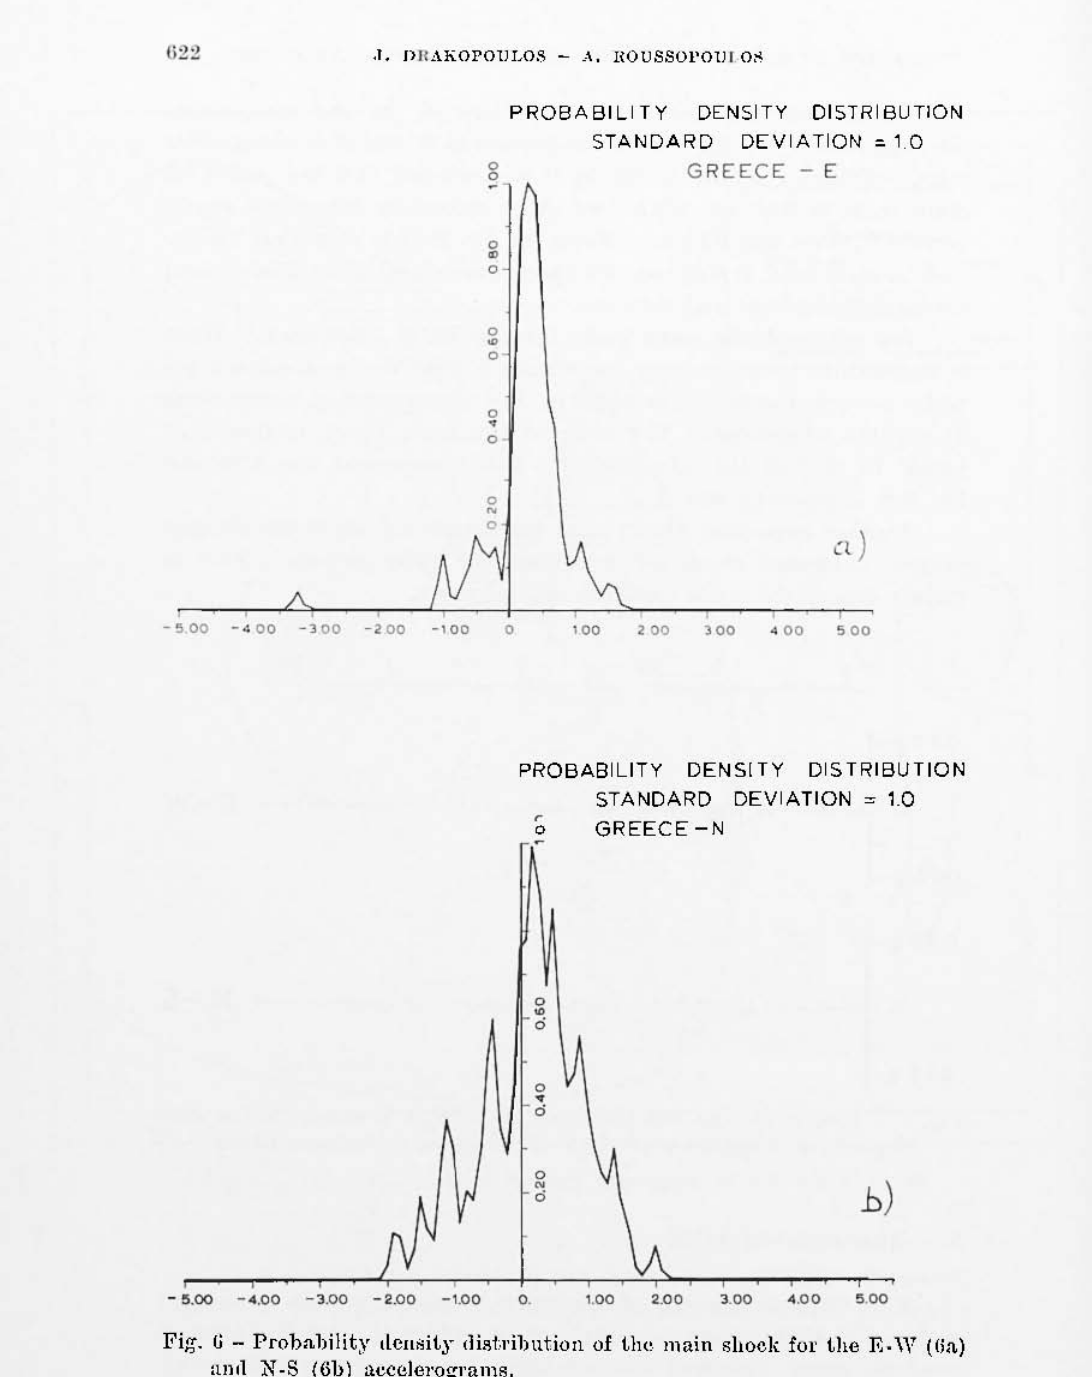
Fig. li - ProbalJility ILCIl~ity dillt.rilmtion 01 t!w main shock fur thc E·W (Ua) allil N-S (6b)